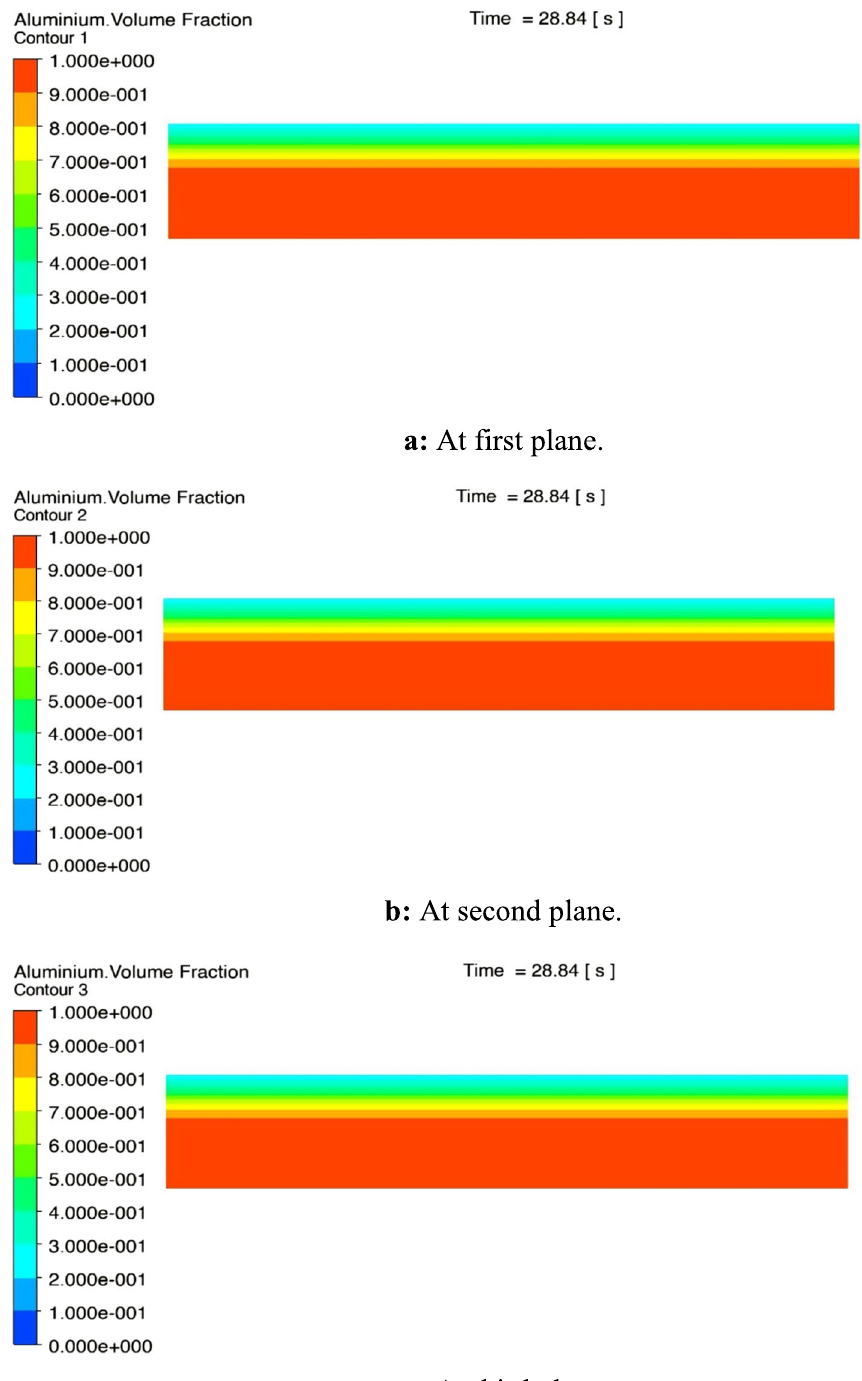
Fig. 11 Contours of aluminium volume fraction at 380 mm/s and 983 K. a At first plane. b At second plane. c At third